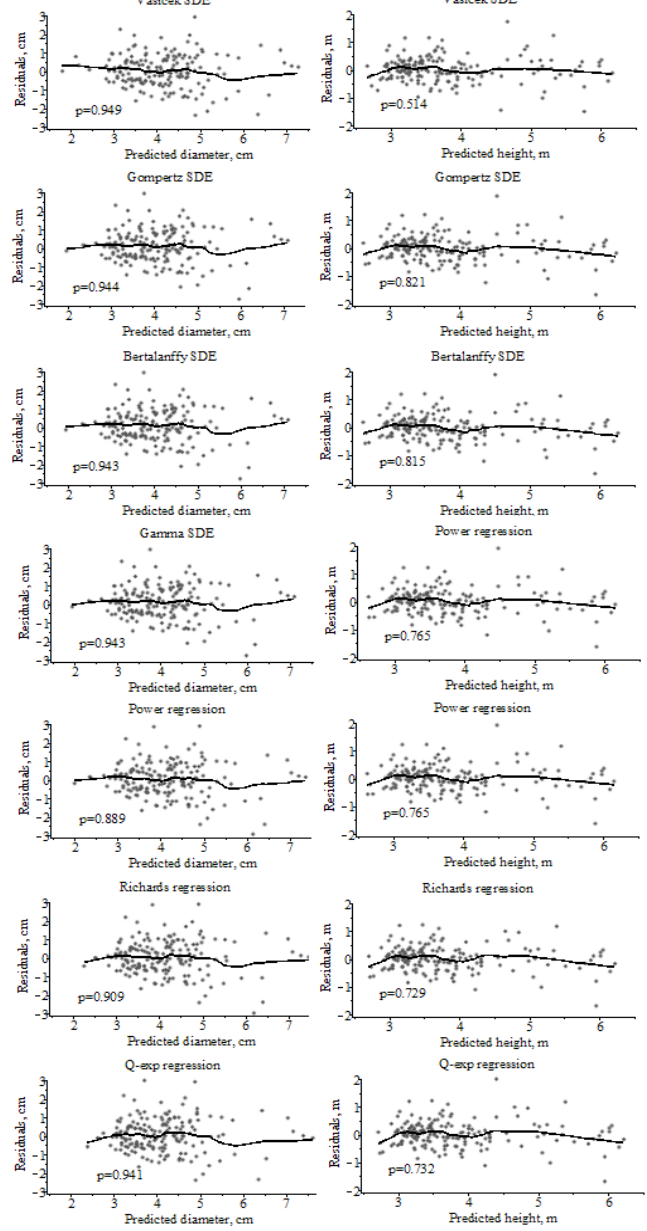
Figure 2. Residuals of the diameter–height ( left ) and height–diameter ( right ) models. The solid black line shows the loess regression, and observed values from the validation dataset are represented by boxes.